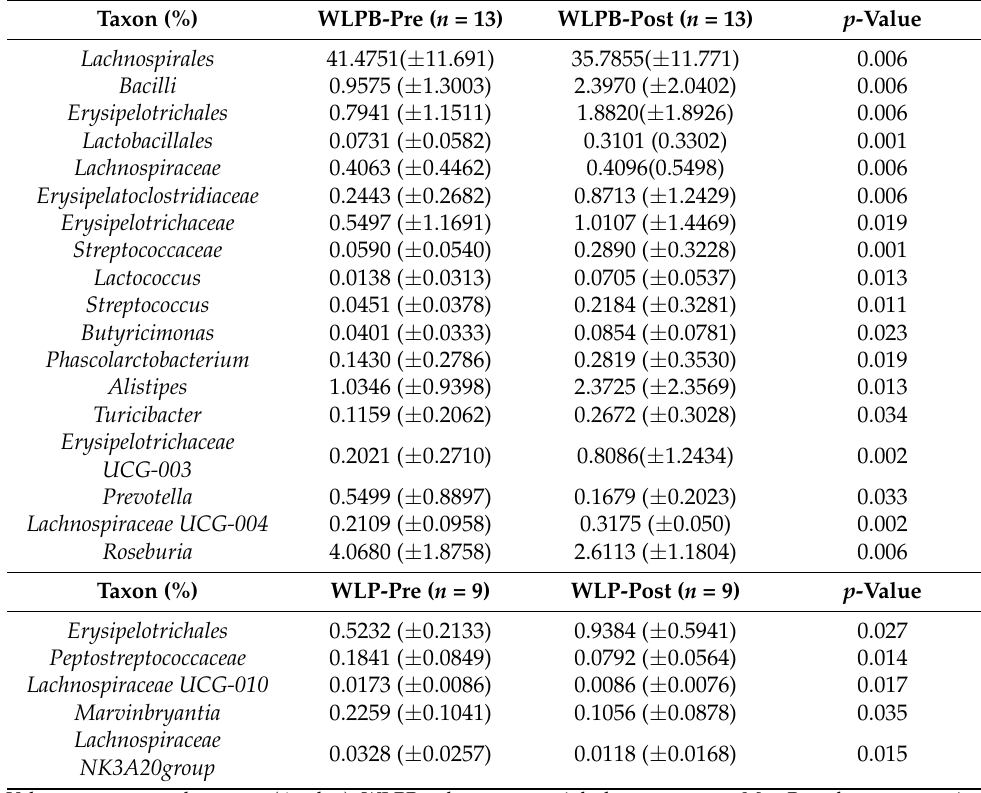
Table 3. Microbial taxa (order, family, genus) differentially present after